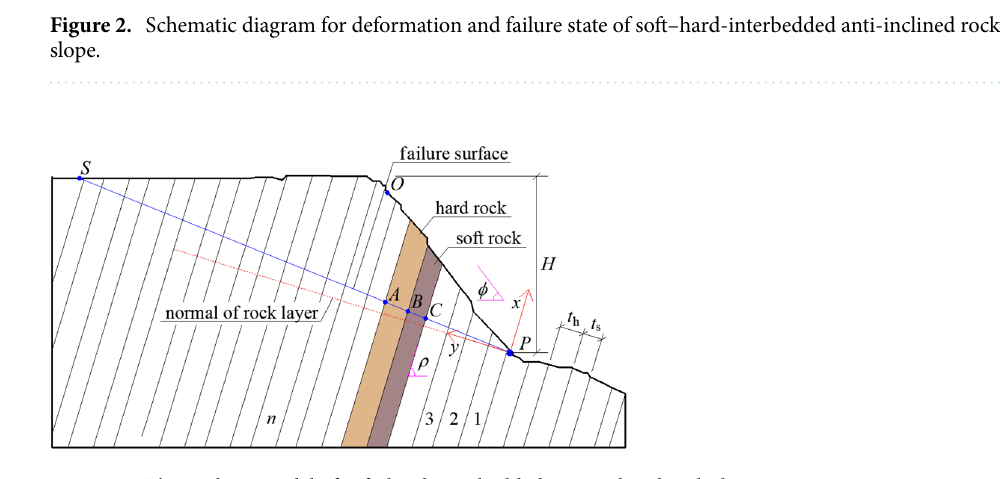
Figure 3. The analysis model of soft–hard-interbedded anti-inclined rock